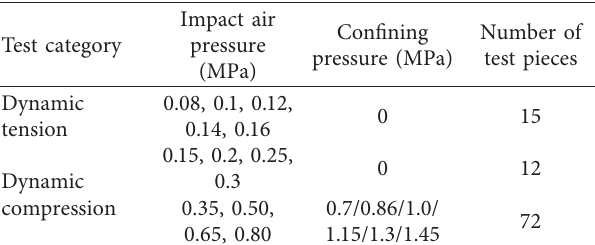
Table 2: SHPB test